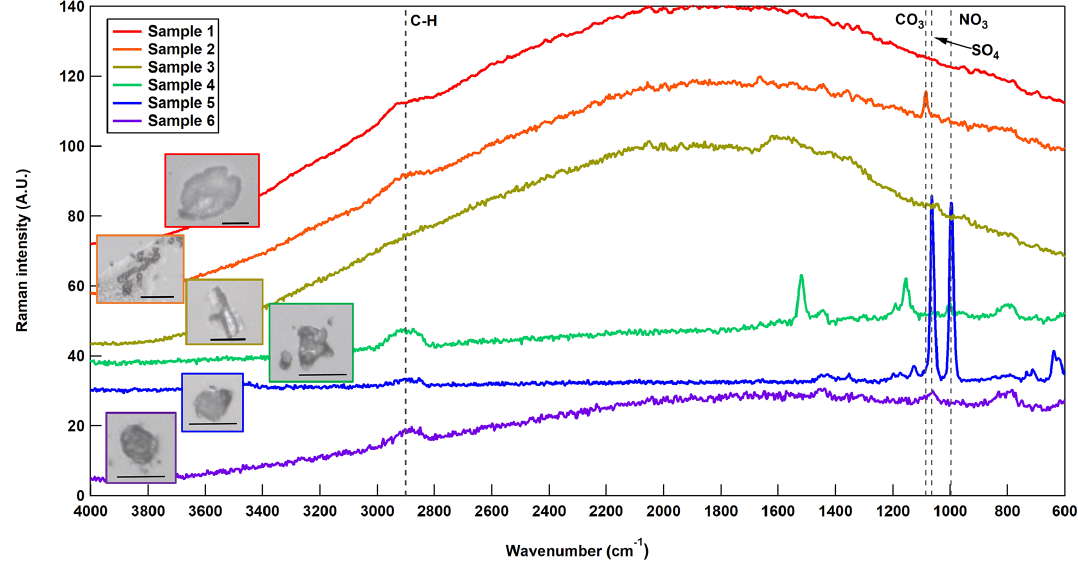
Figure 11. Raman spectra for a representative particle per sample. Characteristic vibrational frequencies for functional groups of organics (C–H; 2800–3000cm − 1 ), carbonates (CO 3 ; 1070–1090cm − 1 ), sulfates (SO 4 ; 972–1008cm − 1 ), and nitrates (NO 3 ; 1032–1069cm − 1 ) are noted for reference. Included are images of the particles that initiated depositional freezing for the Raman spectra shown. The length of the black line in each image represents a scale of